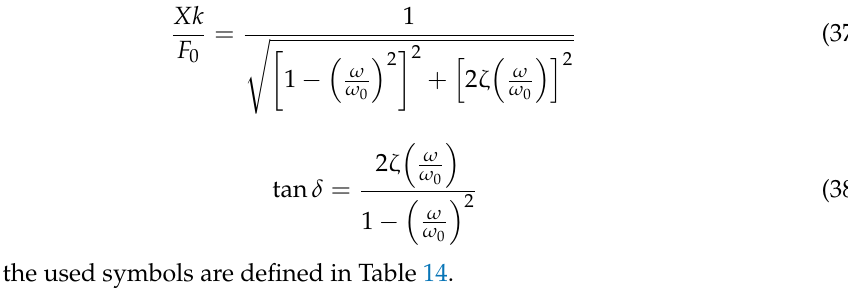
Table 14. The symbols used in the damped vibration equation. Natural frequency